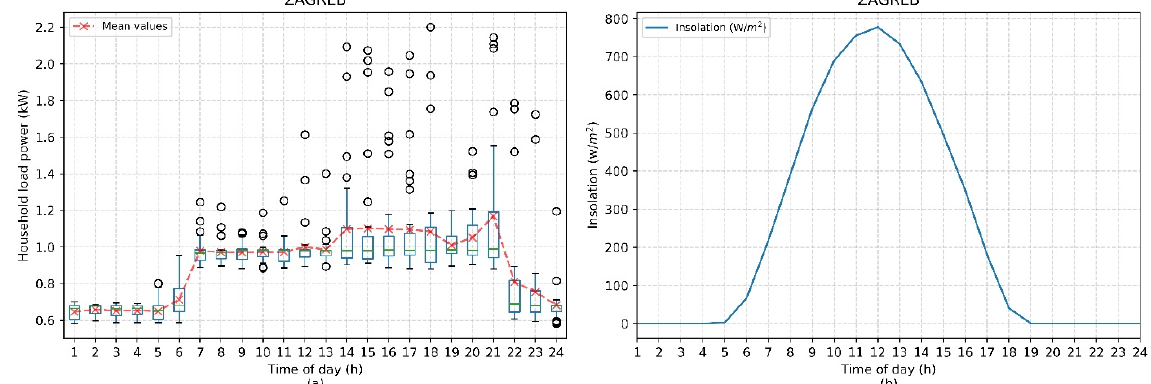
Figure 1. ( a ) Statistically processed samples of load consumption. ( b ) Profile curve of PV insolation.